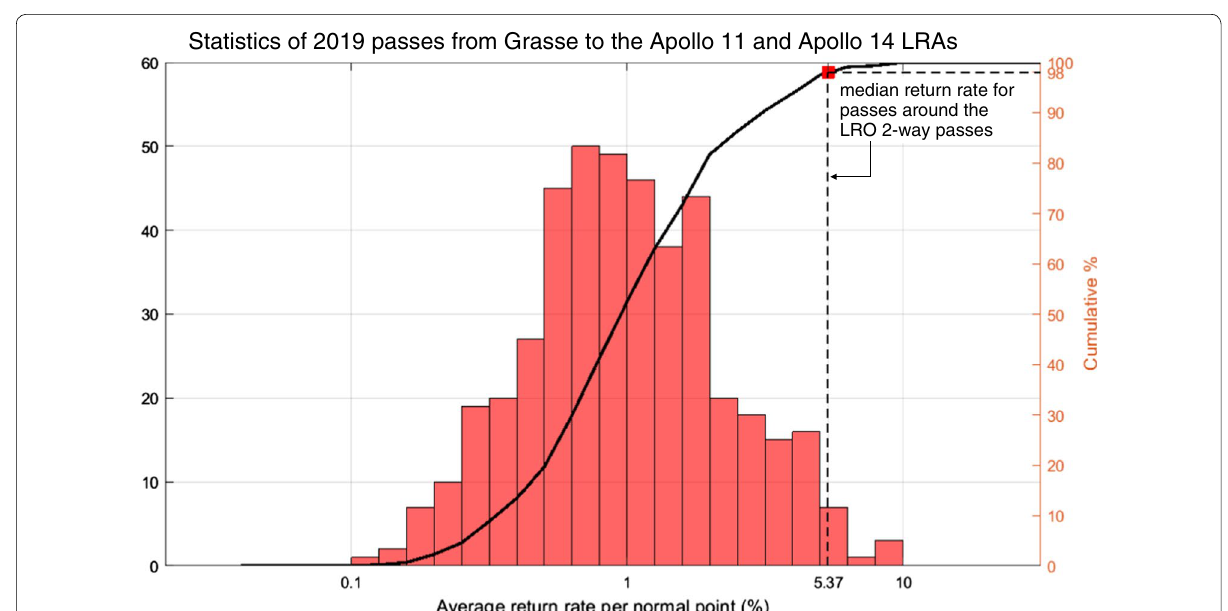
Fig. 10 Average return rate of LLR to surface LRAs. The distribution shows the average return rate per normal point from A11 and A14 LRA from Grasse LLR station for